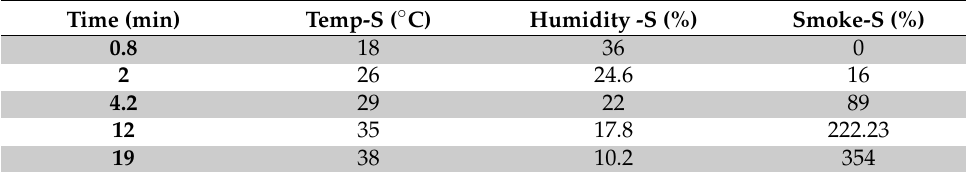
Table 3. Experiment No